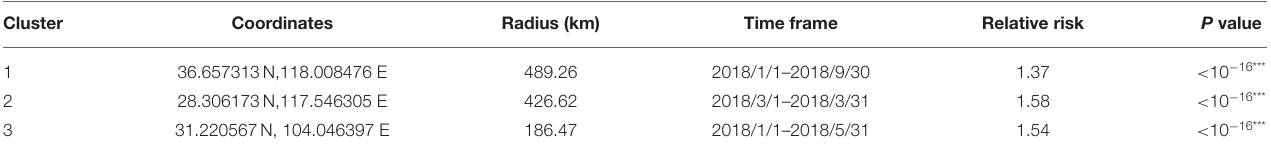
TABLE 5 | Spatial-temporal analysis of PRRSV seroprevalence in China from 2017 to 2021. Cluster